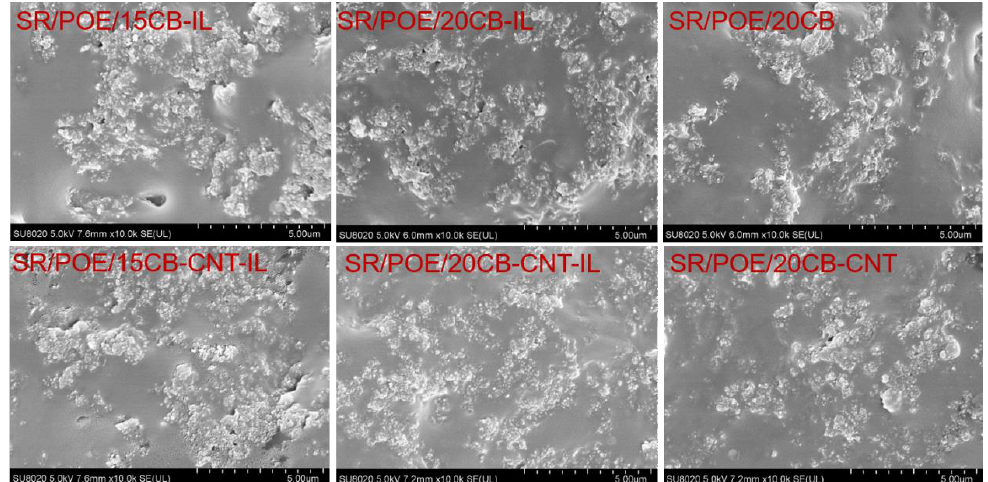
Figure 2. Field-emission scanning electron microscopy (FESEM) images of the fracture surfaces of the SR/POE/CB-IL, SR/POE/CB, SR/POE/CB-CNT-IL, and SR/POE/CB-CNT composites.